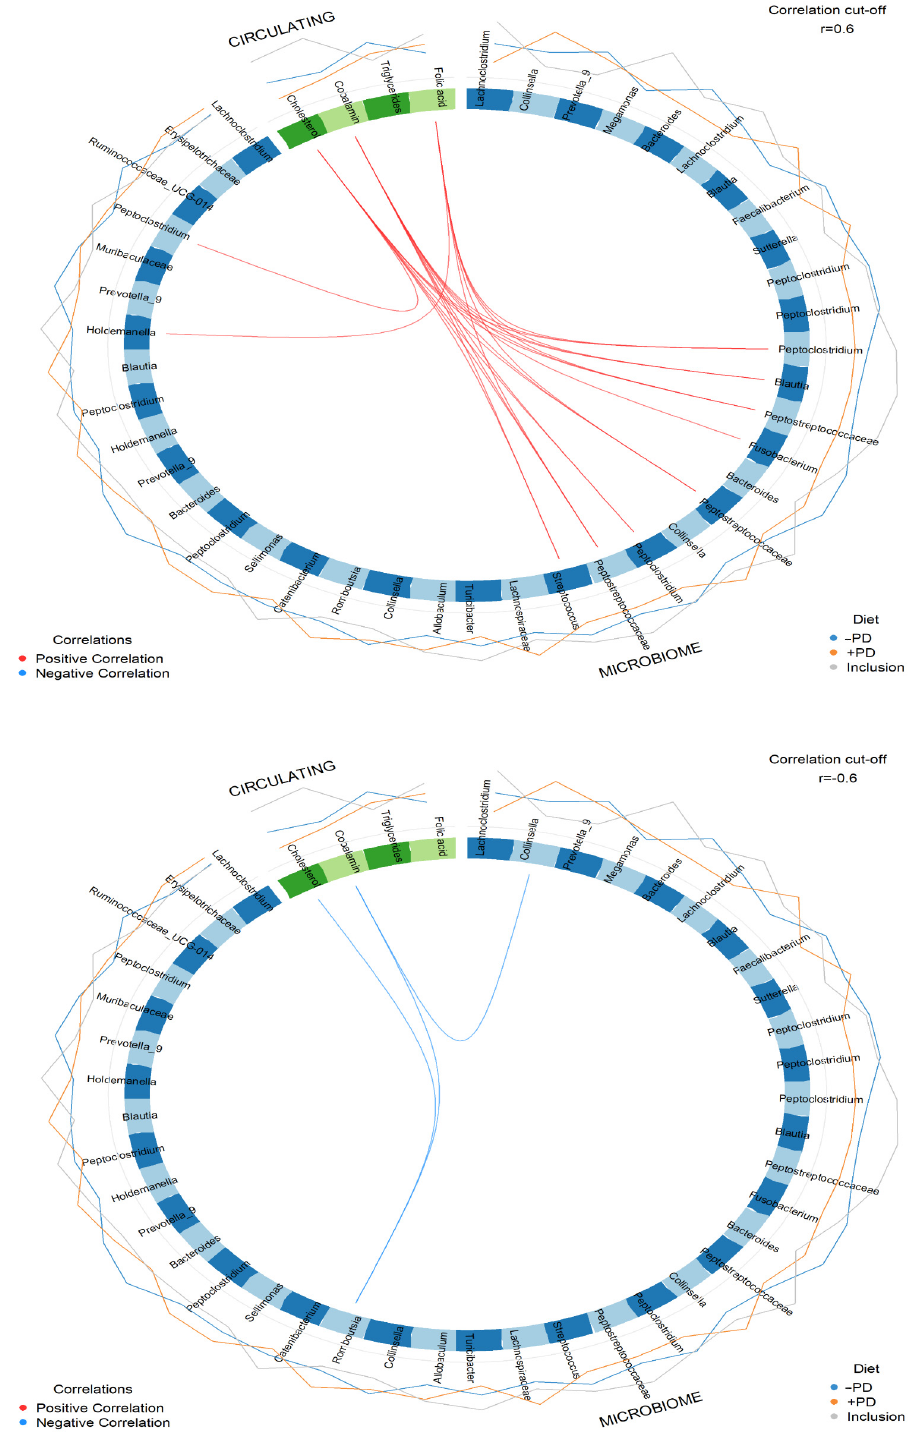
Figure 7. Correlation between faecal microbial abundance and serum cobalamin, folate, cholesterol, and triglycerides. Circos plot illustrating positive correlations (r ≥ 0.6, connecting red lines) and negative correlations (r ≤ − 0.6, connecting blue lines) performed using multiblock sparse partial least squares discriminant analysis of the serum concentrations of cobalamin, folate, cholesterol and triglycerides, and relative abundance of faecal microbes at study inclusion (baseline concentrations, circumferential grey line), when feeding a diet without ( − PD, circumferential blue line) or with 10 9 /kg Enterococcus faecium NCIMB 10415 (+PD, circumferential orange line).